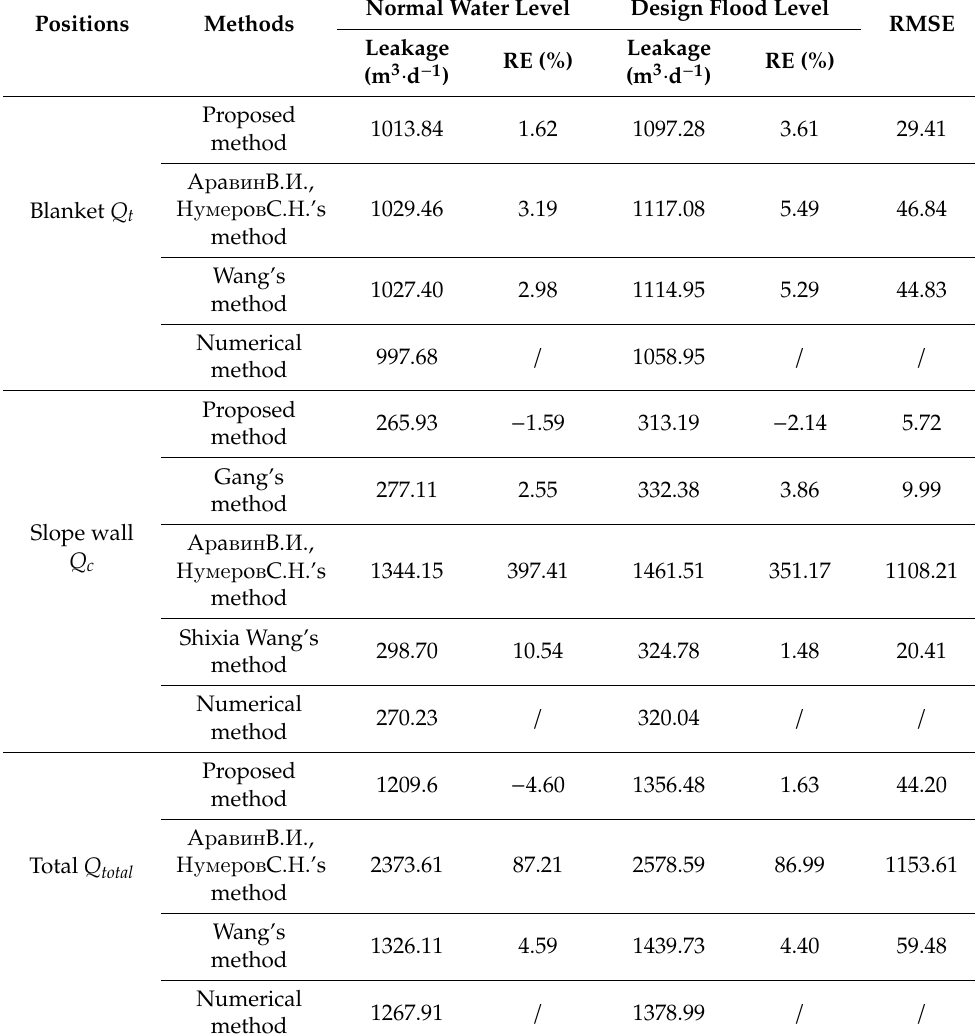
Table 4. Comparison of the calculated results between the calculation method and numerical simulation for the Shangmo composite geomembrane slope-wall rock-fill